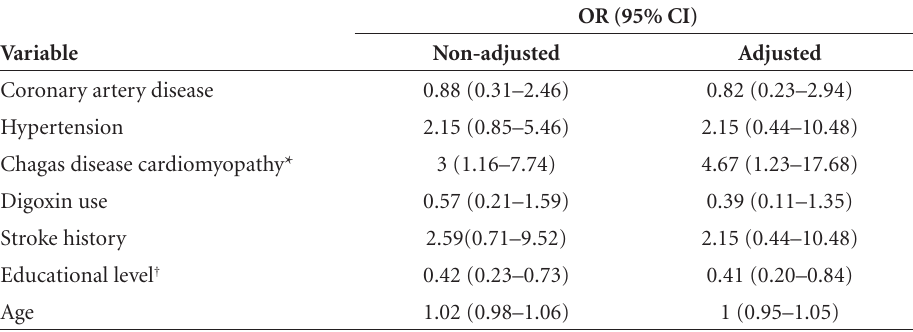
Table 4. Predictors of abnormal delayed recall on Rey-Osterreith Complex Figure Test. Odds ratios (OR) and 95% confidence intervals (CI) are expressed as non-adjusted and adjusted values (multivariable logistic